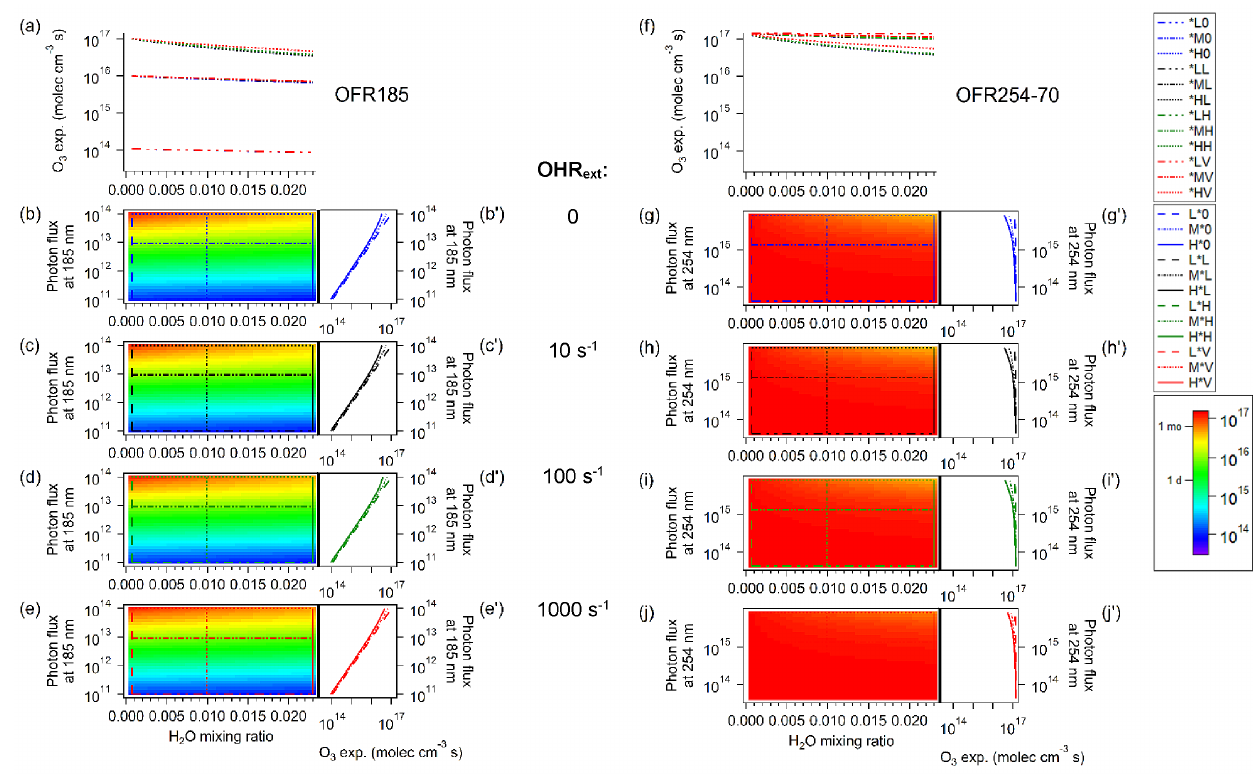
Figure 3. O 3 exposure (in moleculescm − 3 s) vs. the same parameters and in the same format as Fig. 2. Equivalent ambient exposure time (based on average ambient O 3 mixing ratio of 34ppb (Environment Canada, 2014)) is also indicated in the color